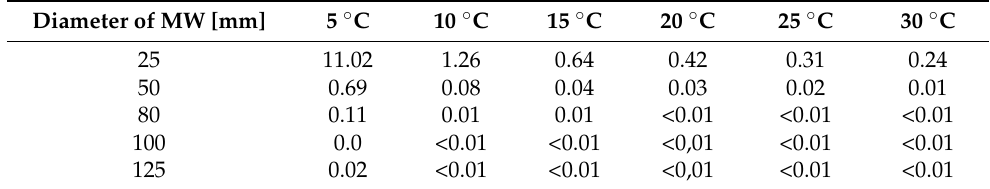
Table 1. Critical thermal gradients for thermal convection in circular columns of pure water calculated for different monitoring well (MW) diameters and temperatures in accordance with Rayleigh [42] and Gershuni and Zhukhovitskii [43]. According to Börner and Berthold [35] a critical Rayleigh number of 148 is assumed. Diameter of MW [mm] 5 ◦ C 10 ◦ C 15 ◦ C